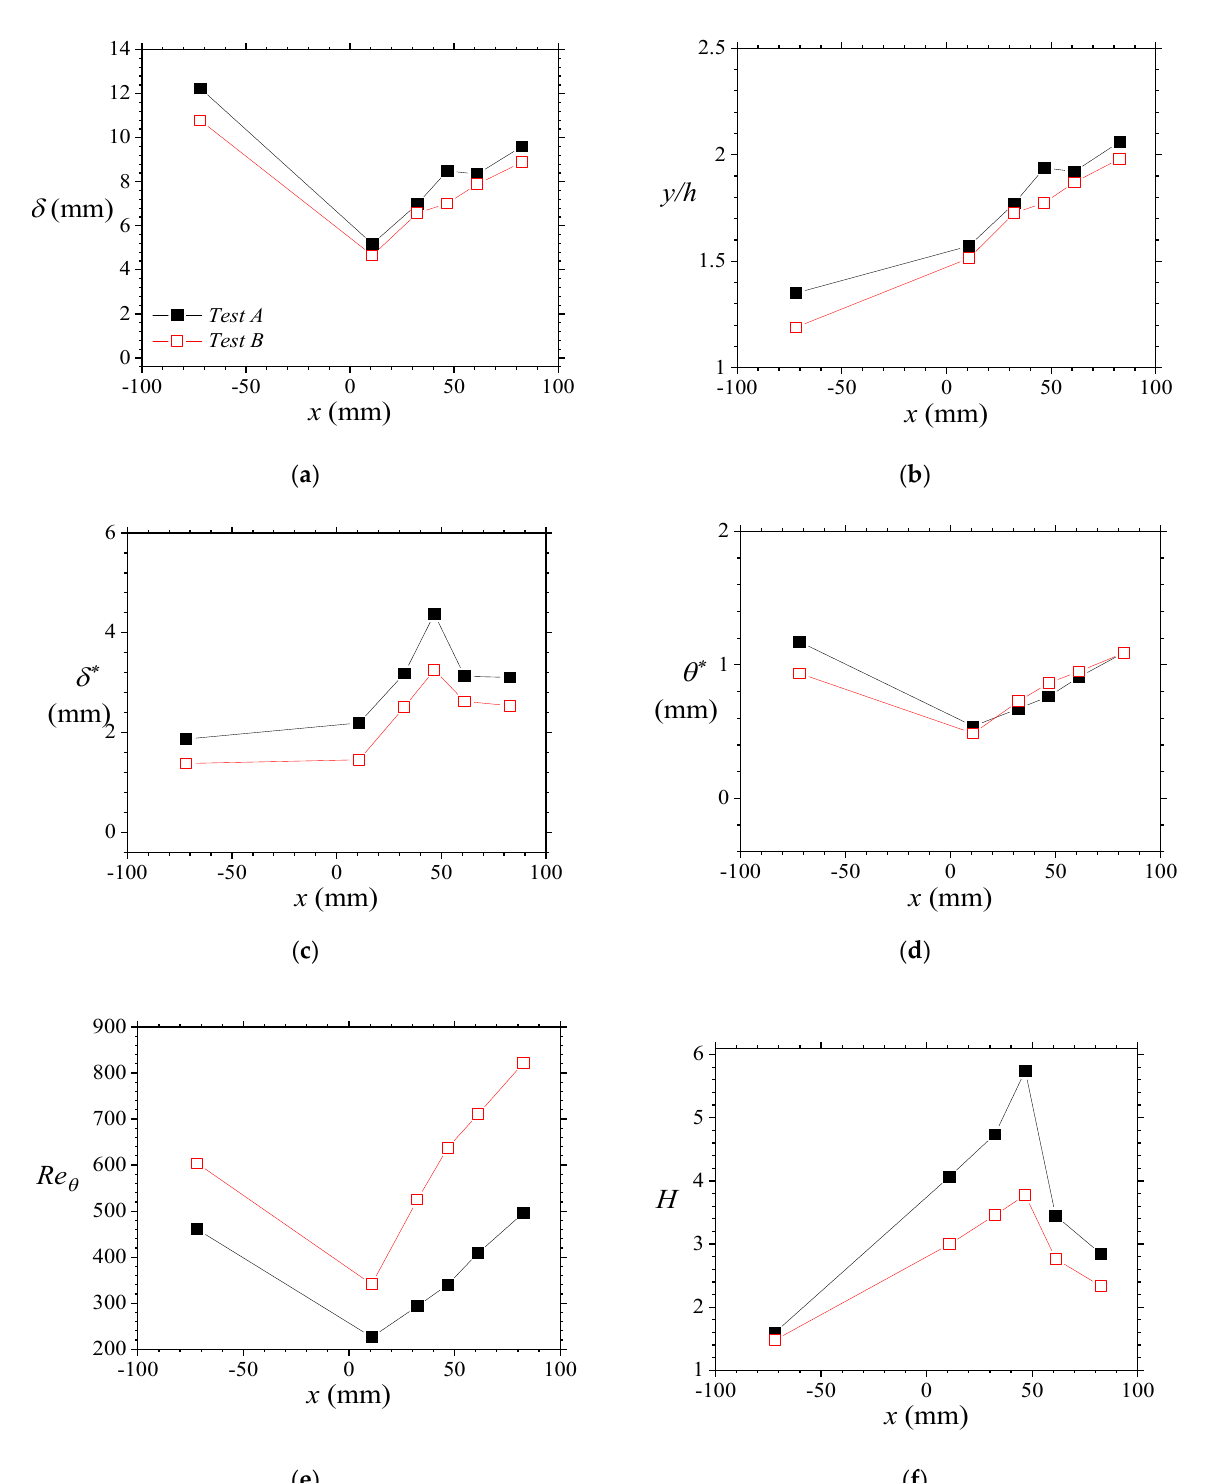
Figure 9. Streamwise variation of ( a ) boundary layer thickness; ( b ) location of the edge of the boundary layer (i.e., y / h values at 0.99< U max > ); ( c ) displacement thickness; ( d ) momentum thickness; ( e ) Reynolds number based on momentum thickness and maximum velocity; and ( f ) shape parameter. Note that the legend showed in ( a ) applies to ( b – f ).